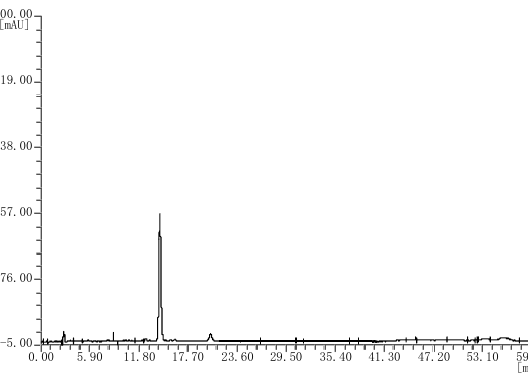
Figure 5. HPLC chromatograms of the black rice extracts.